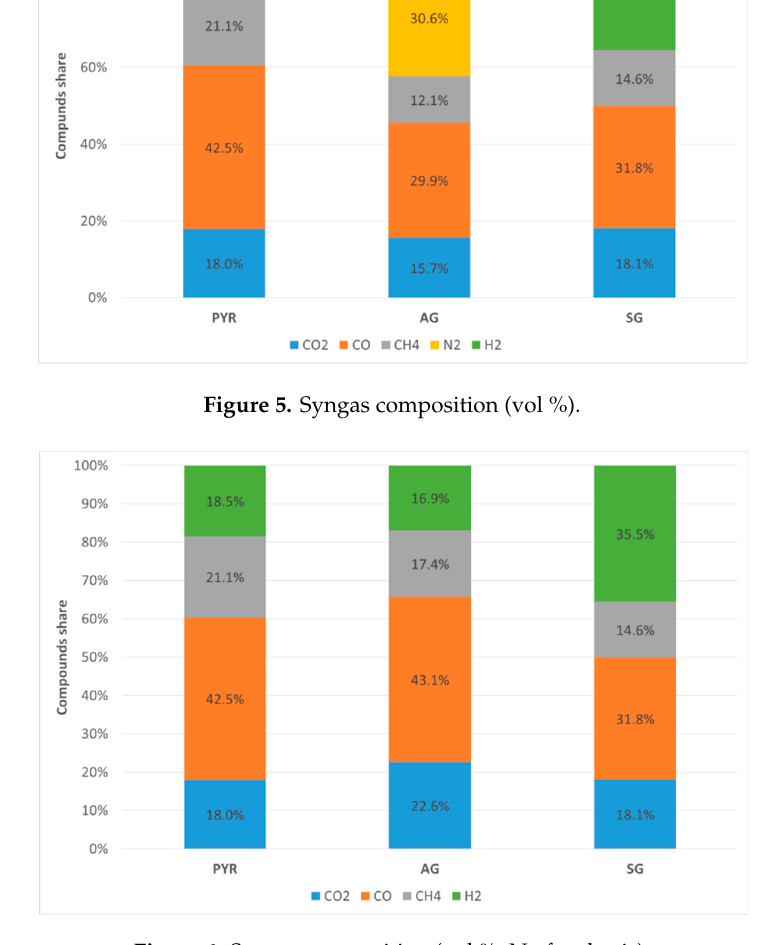
Figure 6. Syngas composition (vol%, N 2 -free basis).